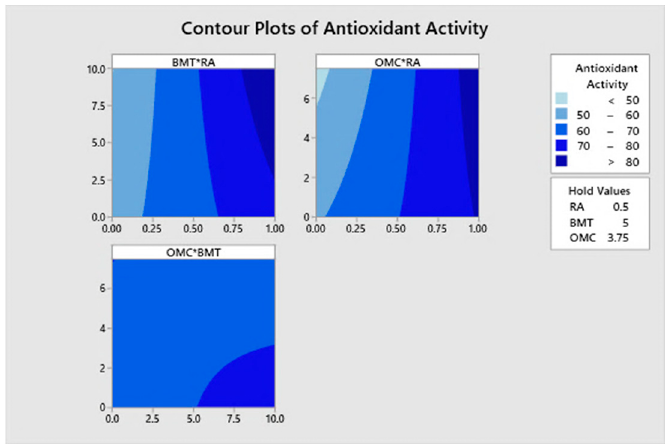
Figure 4. Contour chart for antioxidant